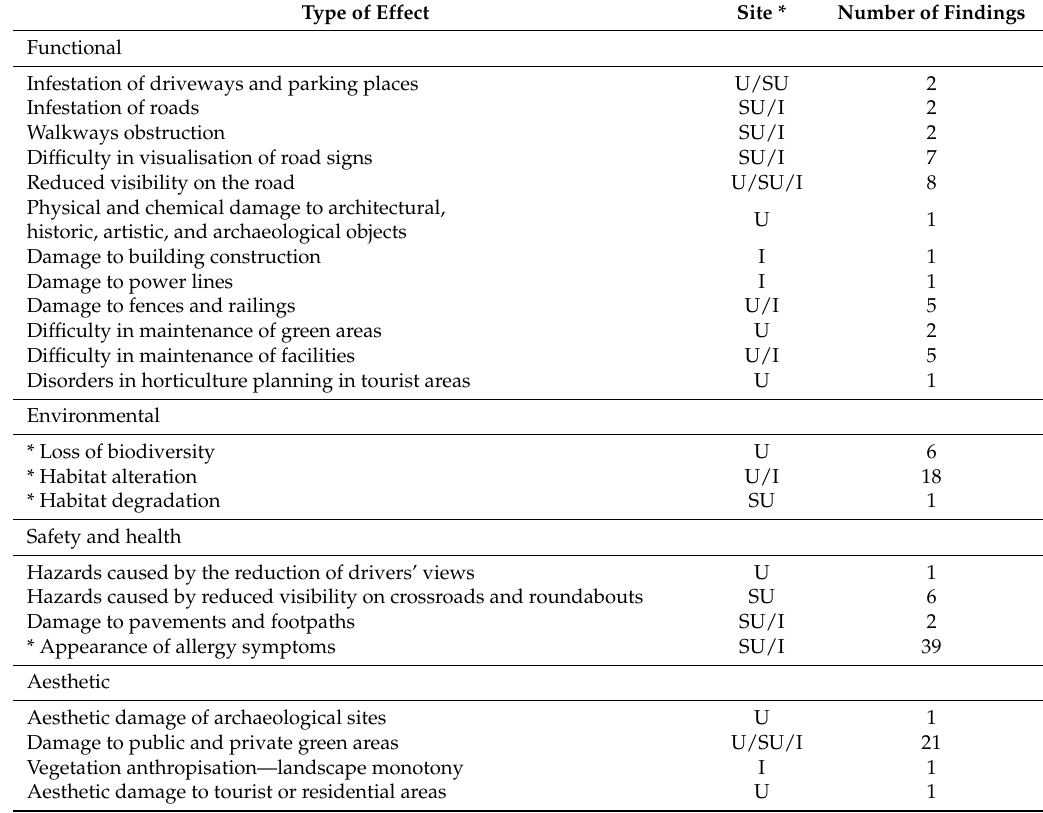
Table 2. Classification, site, and number of effects caused by Ailanthus altissima (Mill.) Swingle presence in urban and suburban